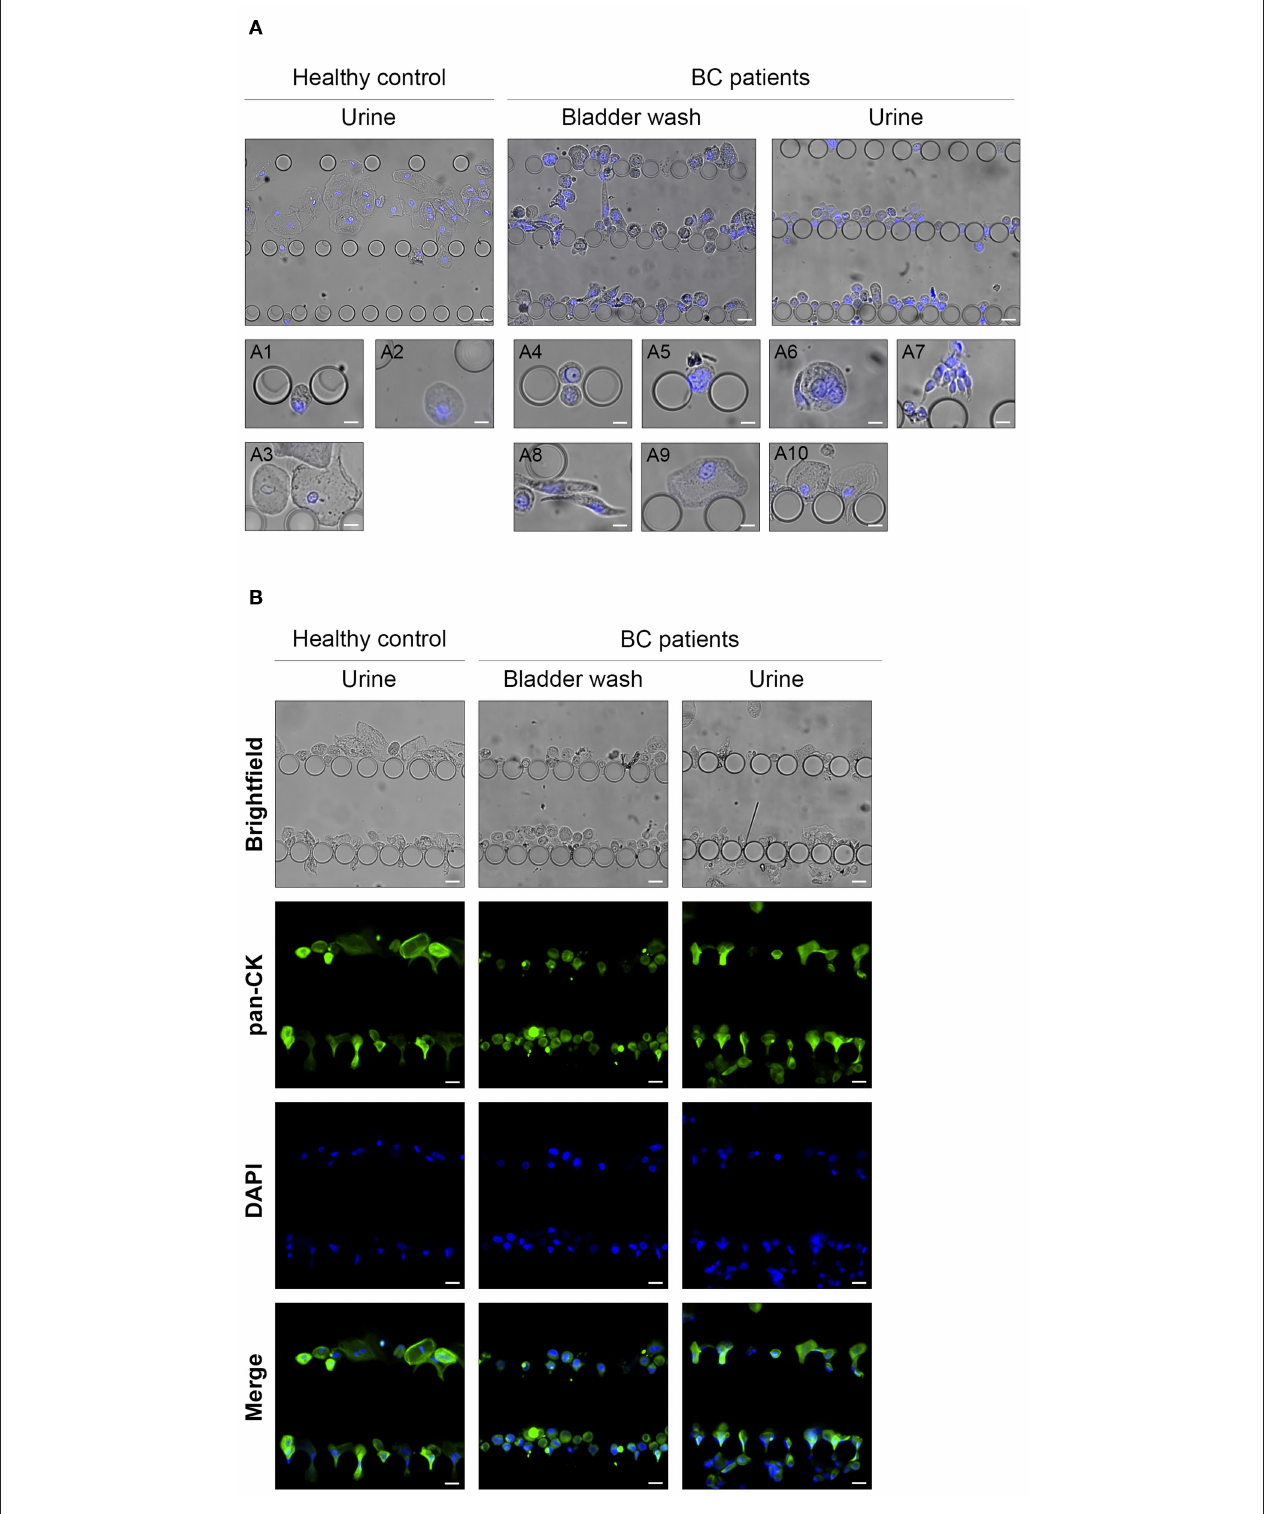
FIGURE 4 | Analysis of UriChip-captured urothelial exfoliated cells from biological samples. (A) Microscopy images showing different types of urothelial exfoliated cells from human voided urine and bladder washes retained along the UriChip and stained for the nuclear marker DAPI (blue): ( A1) basal cell, (A2) intermediate cells, (A3) umbrella cells, ( A4) CMV-like cell, (A5) cell with a large nucleus, (A6) multinucleated cells, (A7) cell clusters, (A8) spindle-shaped cells, (A9) membrane garrulous cells, (A10) cell deformability capacity. (B) Isolated cells trapped between pillars of the UriChip were stained in situ with the anti-pan cytokeratin-FITC antibody (green) and the nuclear marker DAPI (blue). Scale bar, 20 µ